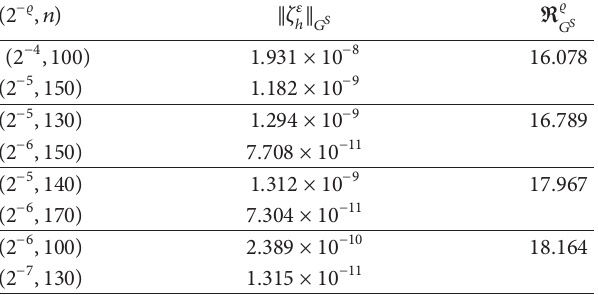
Table 3: The minimum errors of the solution over the pairs (ℎ −1 , 𝑛) in maximum norm when 𝜀 = 5 × 10 −13 . (ℎ −1 ,𝑛) ‖𝜁 𝜀